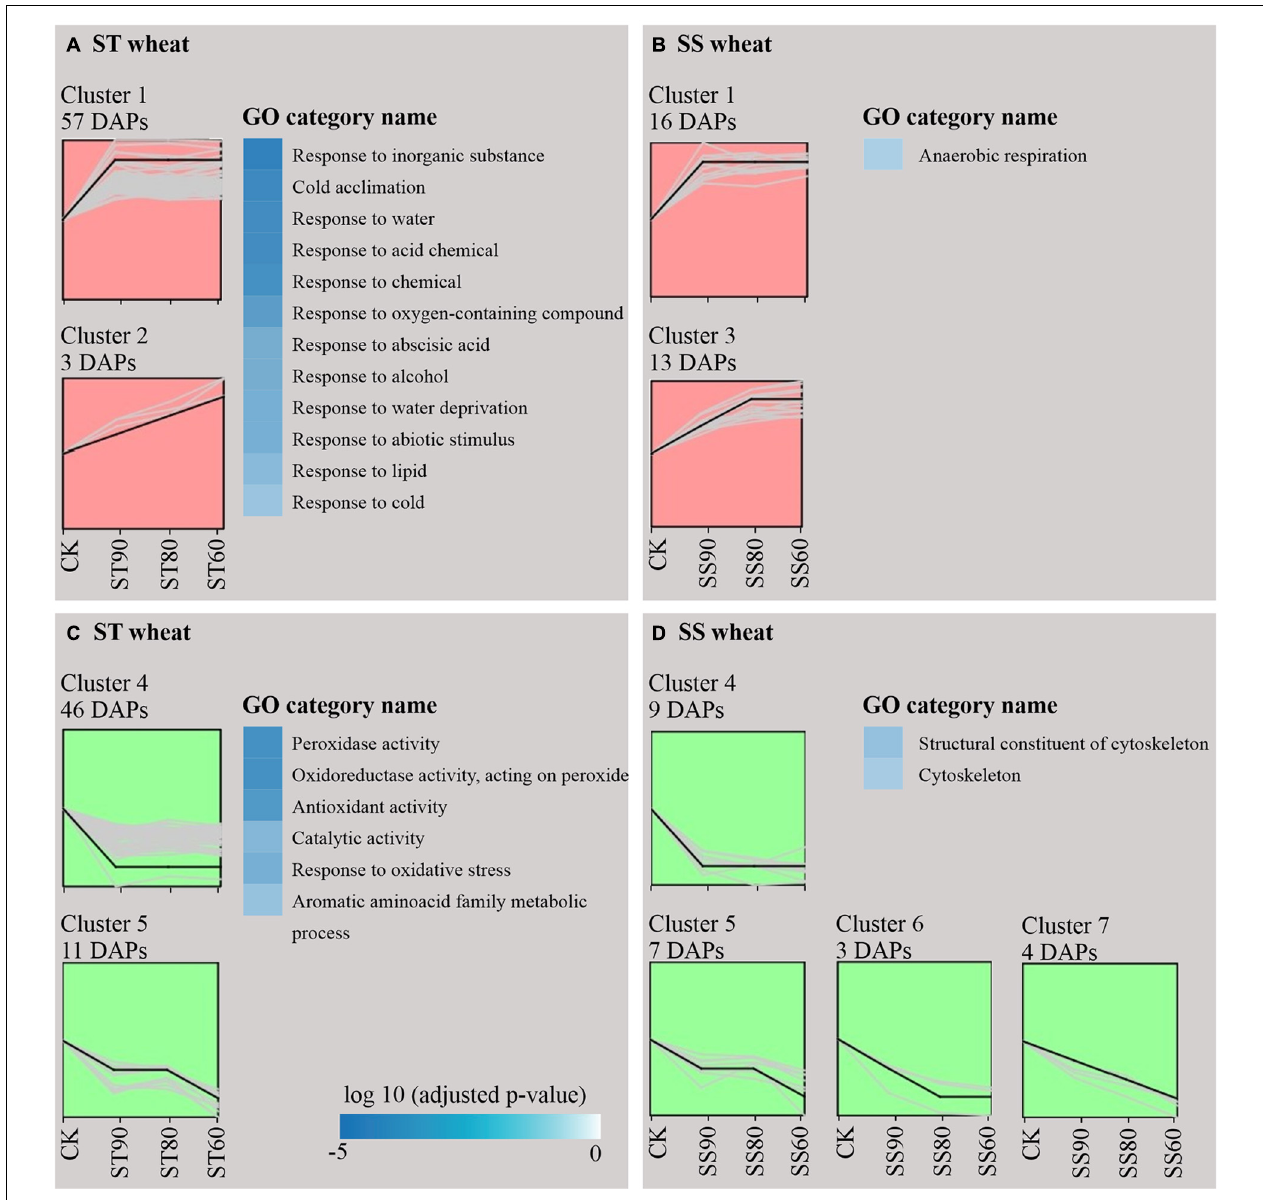
FIGURE 5 | Cluster analysis and GO categories for differentially abundant proteins (DAPs) around (SS90/ST90 and SS60/ST60) and close to the critical node (SS80/ST80) extracted from embryos of imbibed seeds. Up-accumulation of aged storage-tolerant (ST) seeds (A) and aged storage-sensitive (SS) seeds (B) and down-accumulation of ST seeds (C) and SS seeds (D) . GO category represent annotation in DAPs with significant trend of upregulation (red) or downregulation